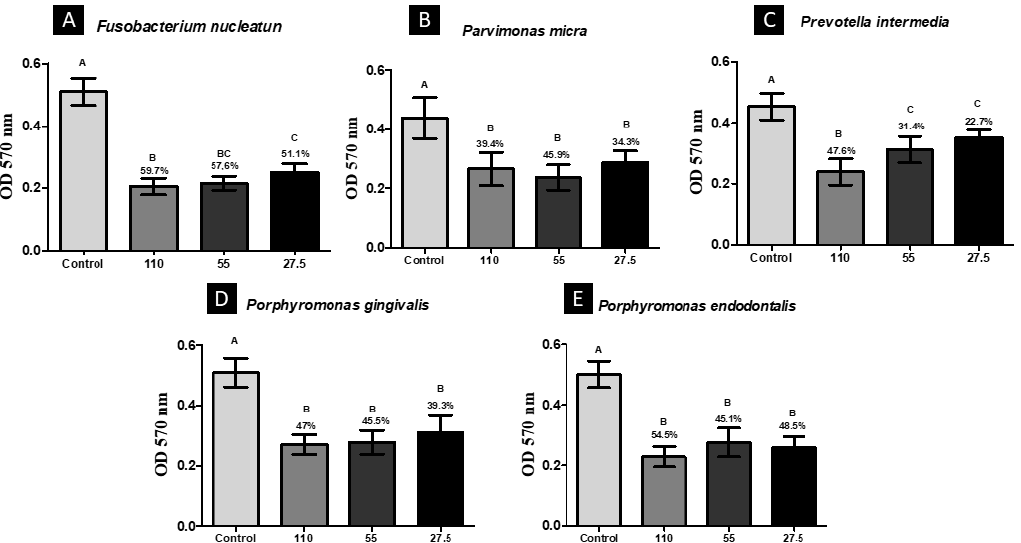
Figure 3. Viability reduction after contact for 5 min with the BGP-AqExt. Legend: OD—Optical Density; Control: BHI broth; Values expressed in mg/mL; Different uppercase letters ( A – E ) indicate statistically significant difference (ANOVA, Tukey, p <